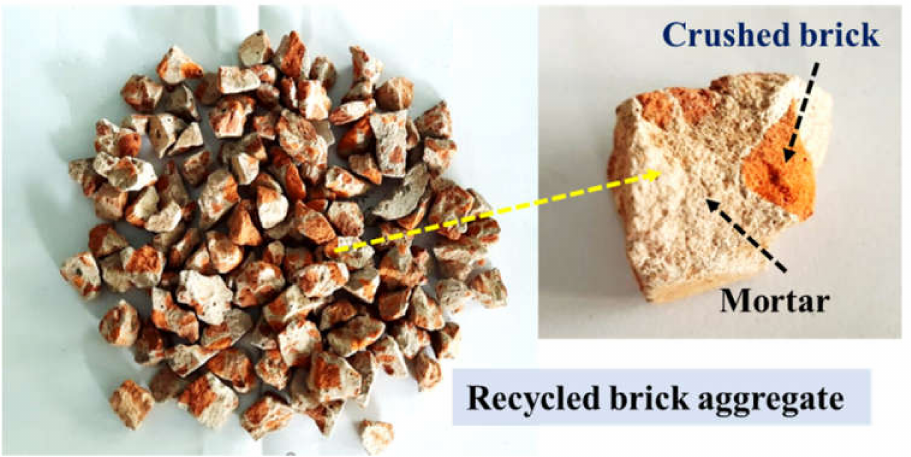
Figure 1. Recycled brick aggregate (RBA). Table 1. Aggregate gradation.